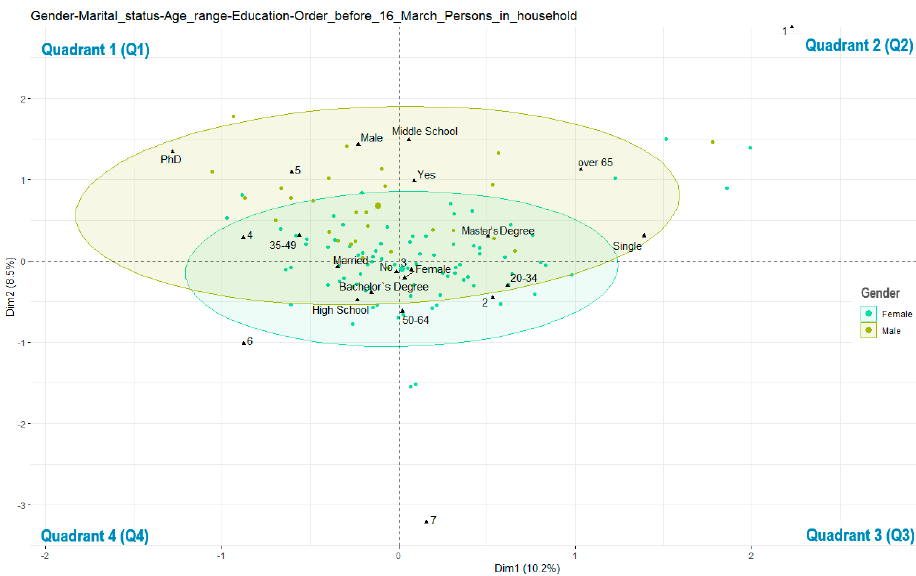
Figure 3. Biplot with multivariate correspondence depending on gender, marital status, age range, persons in household, education, and purchase decision of fresh vegetables directly from producers before March 16.